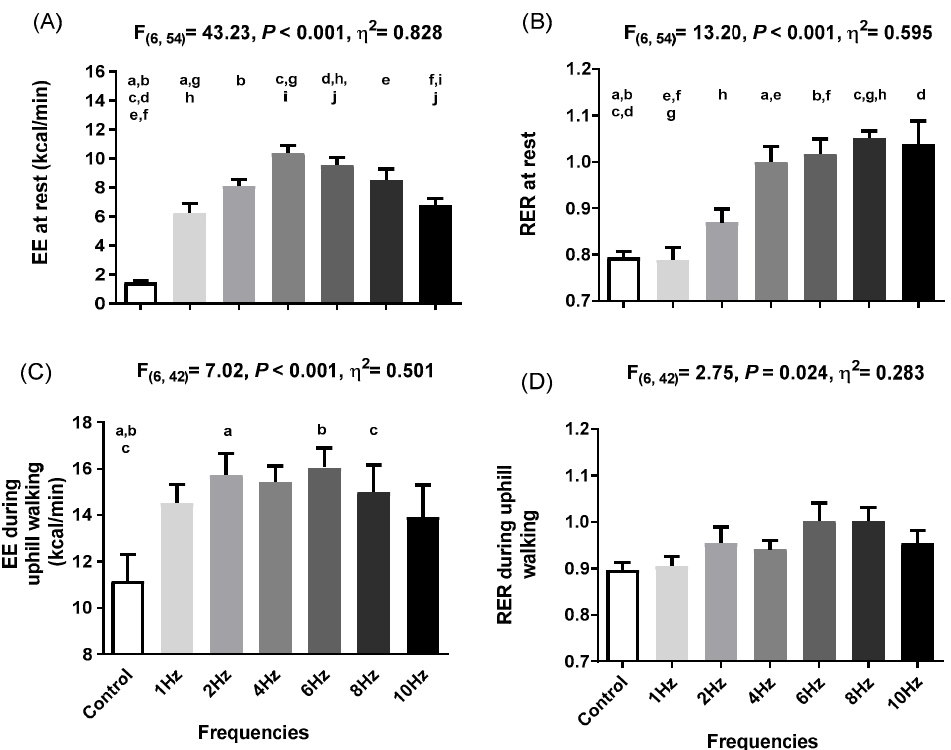
Figure 3. ( A ) Energy expenditure (EE) at rest (n = 10) when applying different frequencies of whole-body electromyostimulation; ( B ) respiratory exchange ratio (RER) at rest (n = 10) when applying different frequencies of whole-body electromyostimulation; ( C ) EE during uphill walking (n = 8) when applying different frequencies of whole-body electromyostimulation; ( D ) RER during uphill walking when applying different frequencies of whole-body electromyostimulation. EE when applying different frequencies of whole-body electromyostimulation. p -values from repeated measures analysis of variance (ANOVA). Similar letters represent differences between experimental conditions as determined by post hoc Bonferroni analysis.